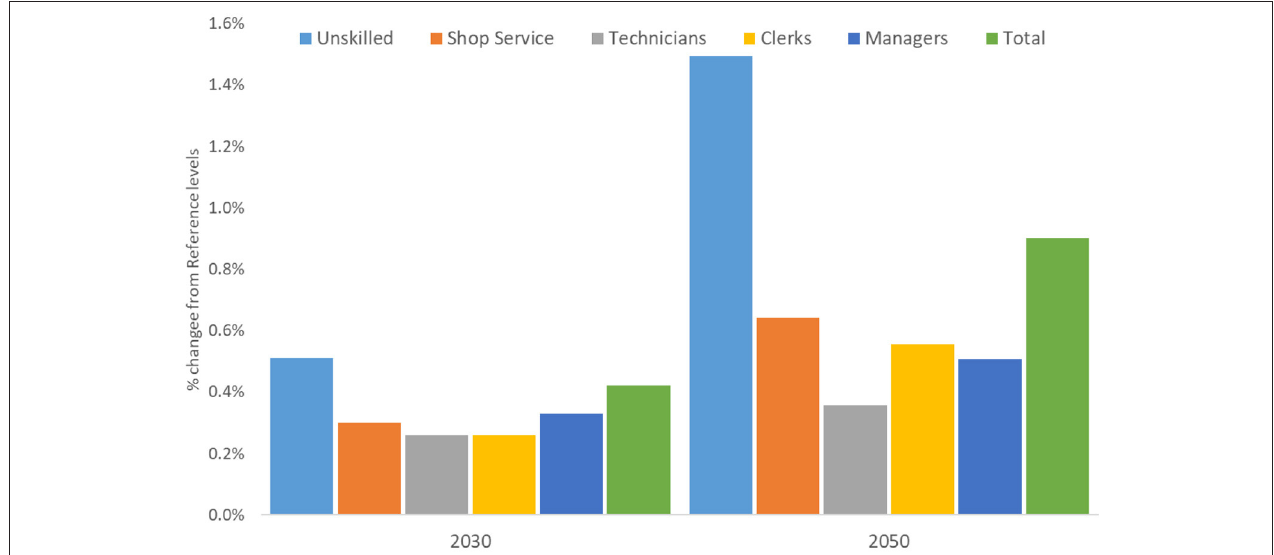
FIGURE 16 | Changes in global unemployment by occupation in 2DEG compared to